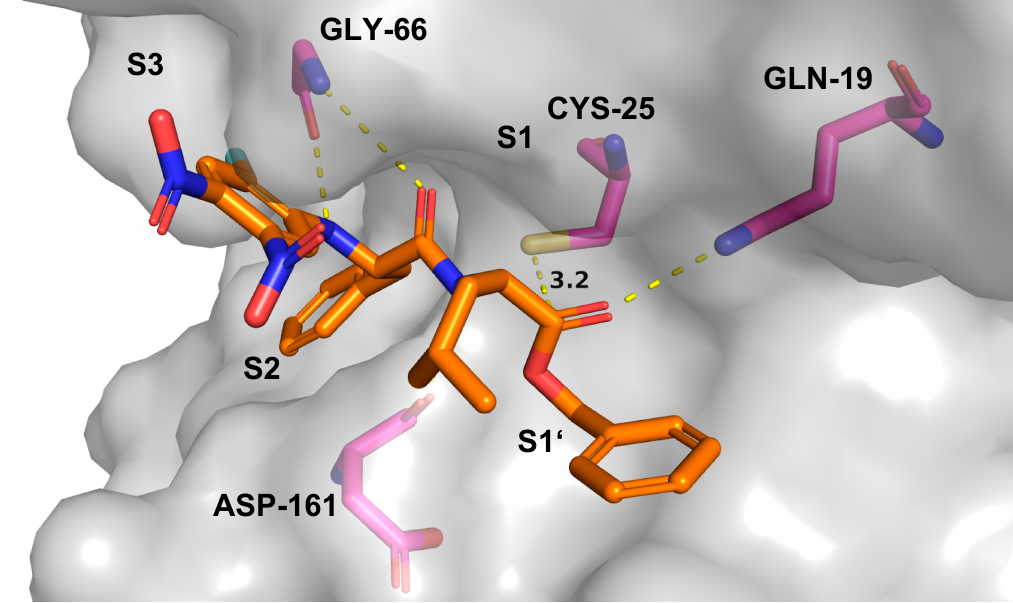
Figure 7. Substrate-like binding mode of ester 7 . Light grey: solvent accessible surface of rhodesain; magenta: carbon atoms of rhodesain amino acid residues; orange: carbon atoms of ester 7 ; blue: nitrogen; red: oxygen; yellow: sulfur; cyan: fluorine.